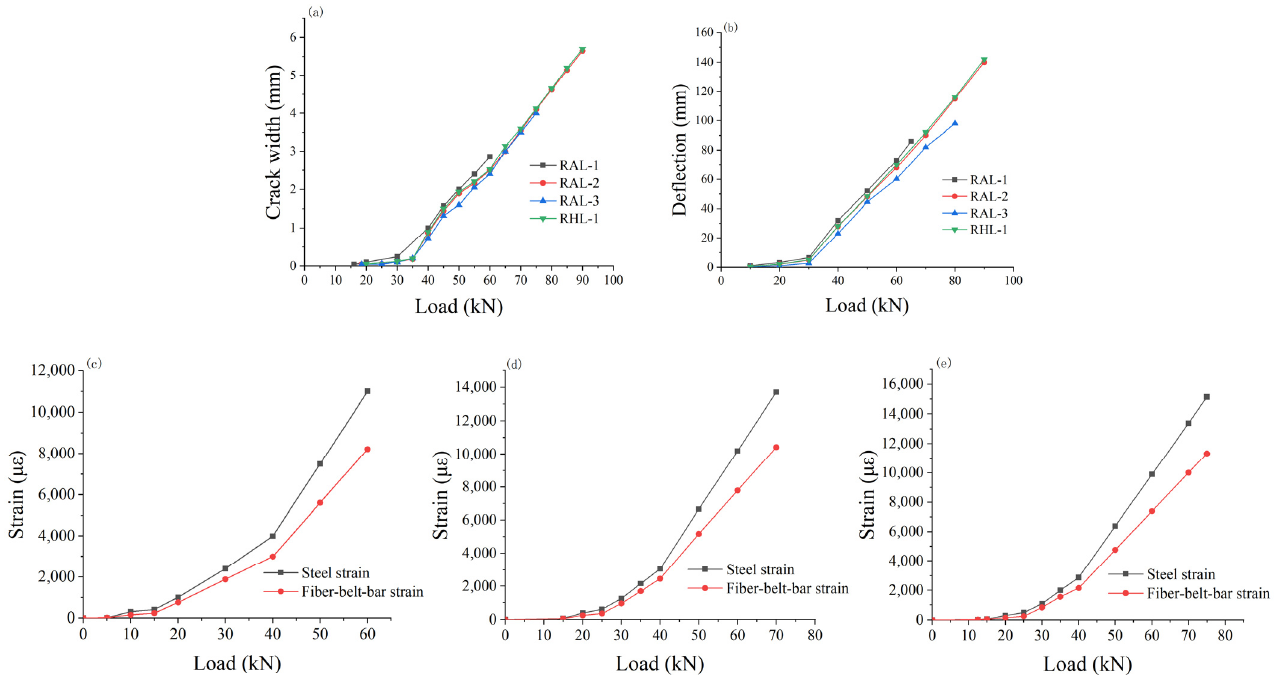
Figure 7. The test related data results. ( a ) Maximum crack width curves of specimens under different loads, ( b ) Deflection curves of specimens under different load, ( c ) Stress-strain curves of specimen RAL-1 under different loads, ( d ) Stress-strain curves of specimen RAL-2 under different loads, ( e ) Stress-strain curves of specimen RAL-3 under different loads .